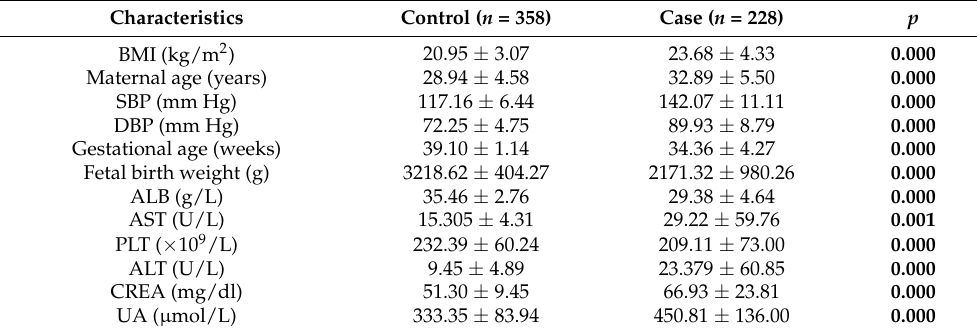
Table 1. Clinical characteristics overview of the study population.